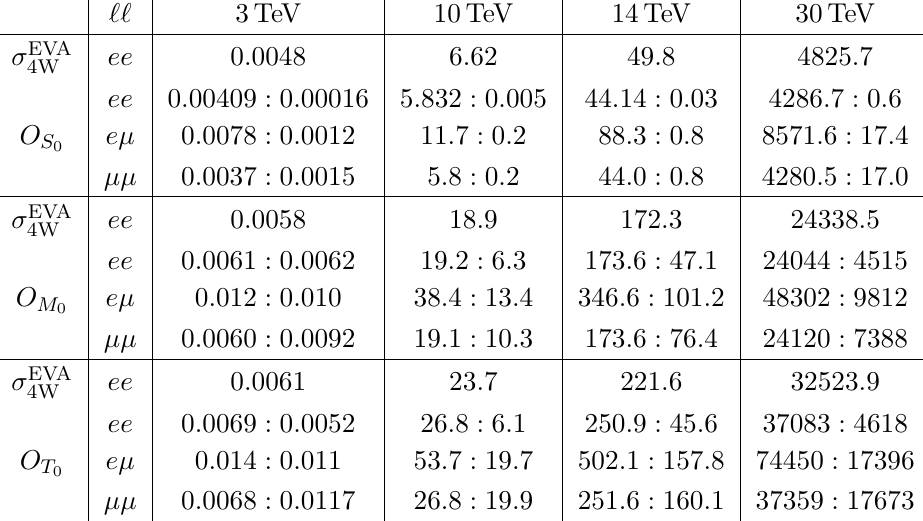
for ee final 4W